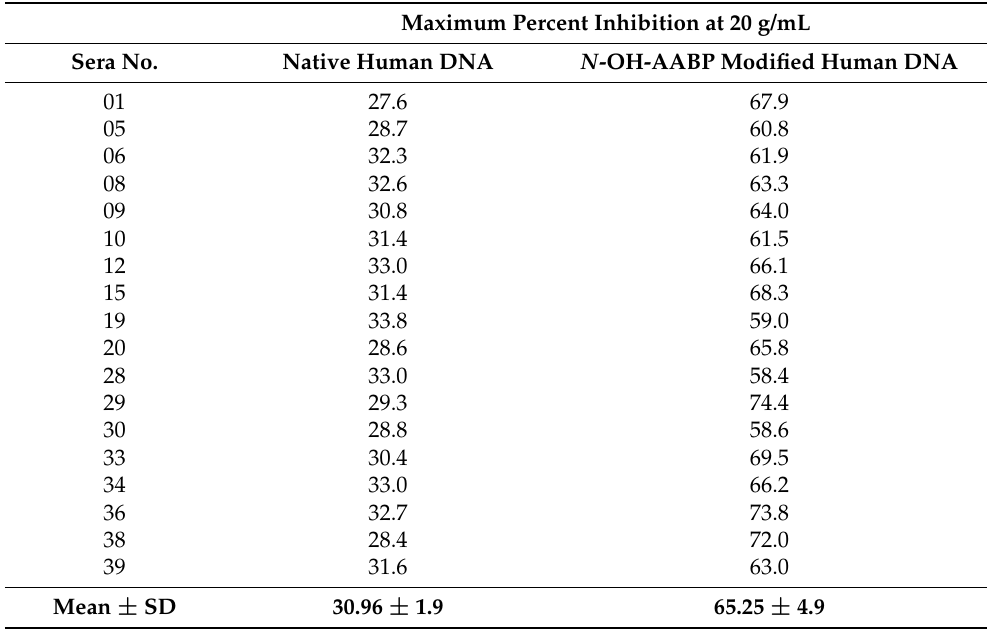
Table 1. Competitive inhibition data of IgG from bladder cancer patients (smoker group).